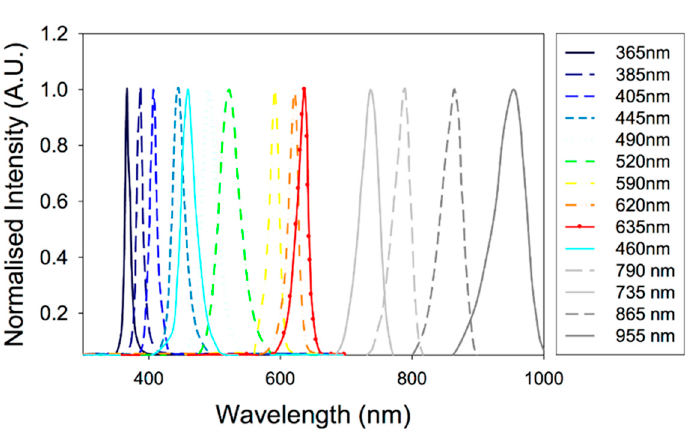
Figure 4. Optical spectra for a range of commercially available LEDs. Reproduced with permission from T. J. Allen and P. C. Beard, Biomedical Optics Express, Vol.7, Article ID1260, 2016; licensed under